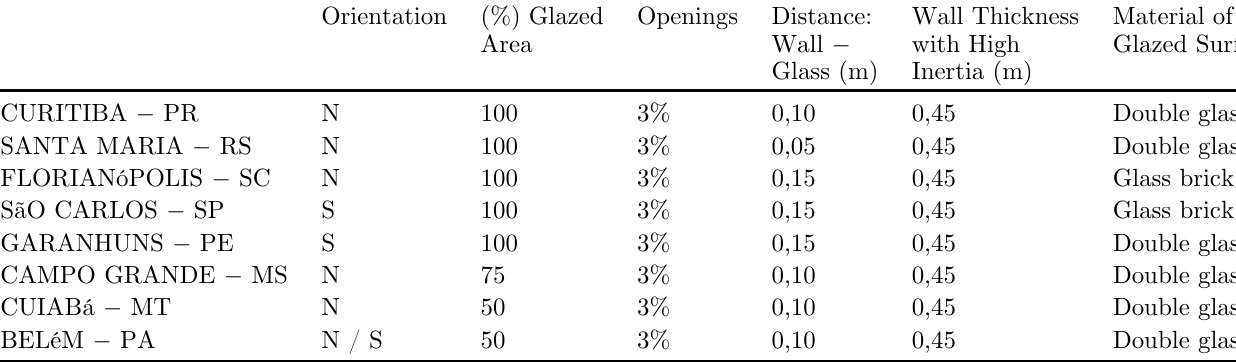
Table 5. Constructive recommendations for the use of Trombe walls in the cities analyzed.